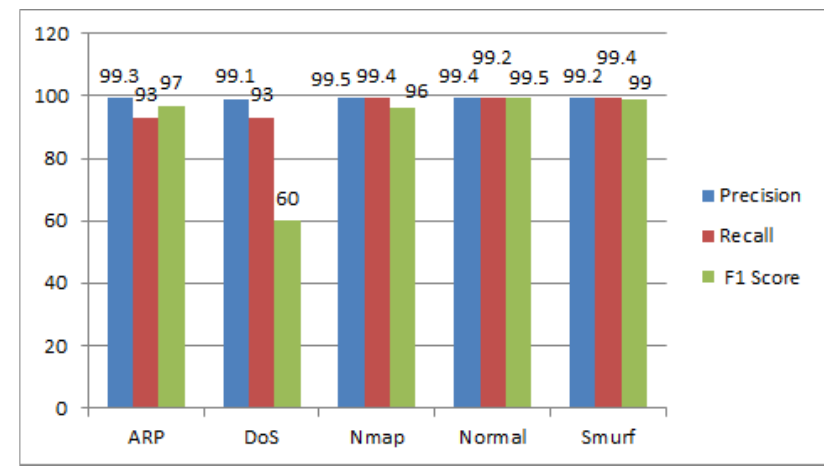
Figure 11. Performance of the proposed model on various attacks.